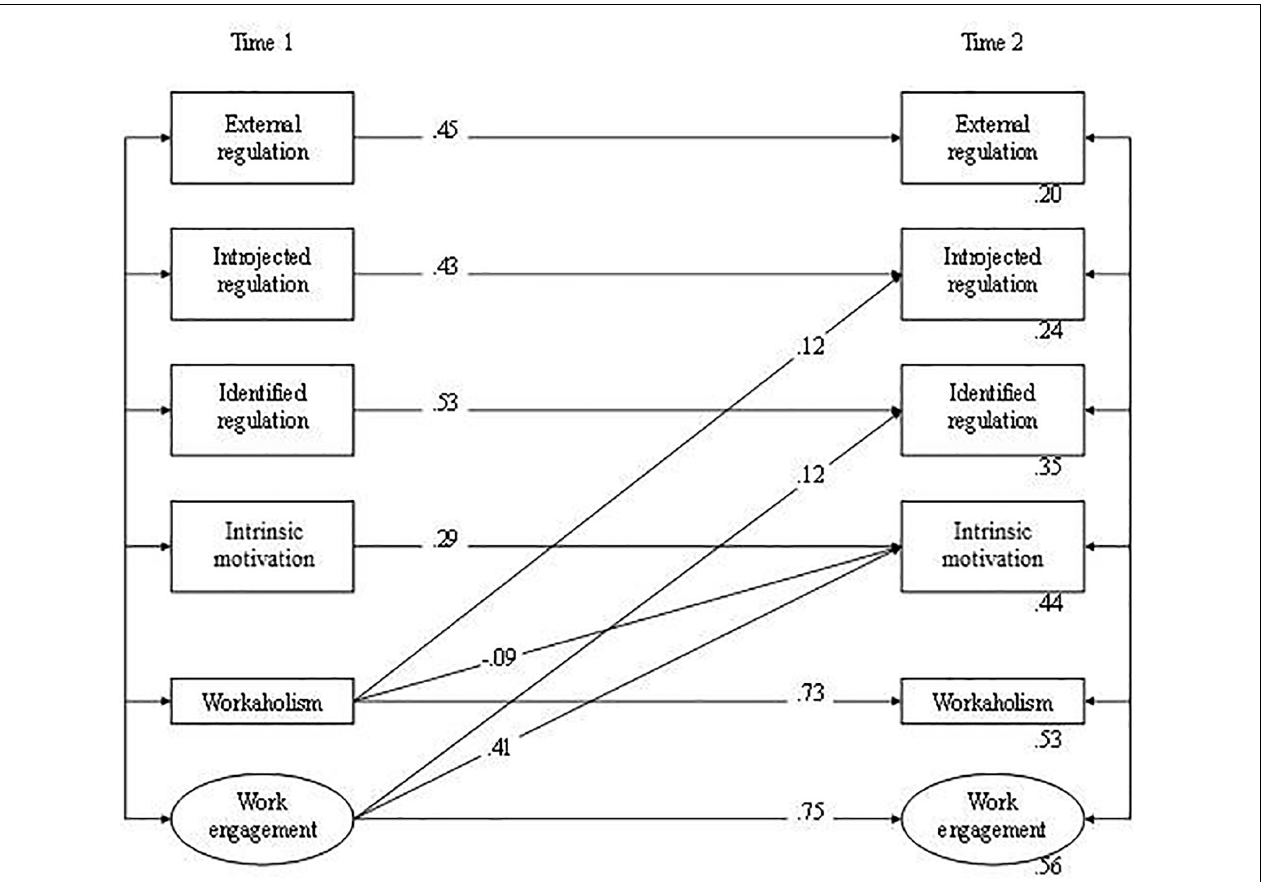
FIGURE 3 | Final SEM model: relations between motivation and heavy work investment (the reversed casuality model, model